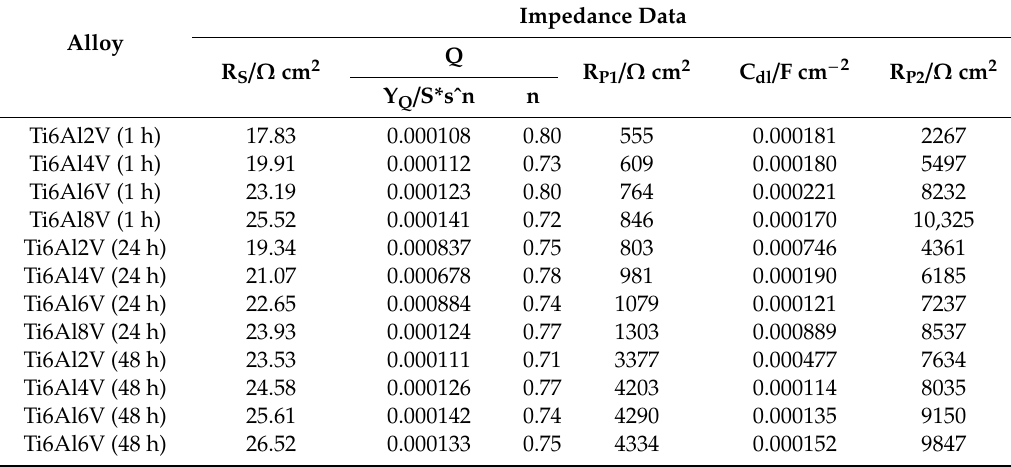
Figure 2. Nyquist plots measured for the di ff erent TiAlV alloys after 24 h exposure in the NaCl solution.